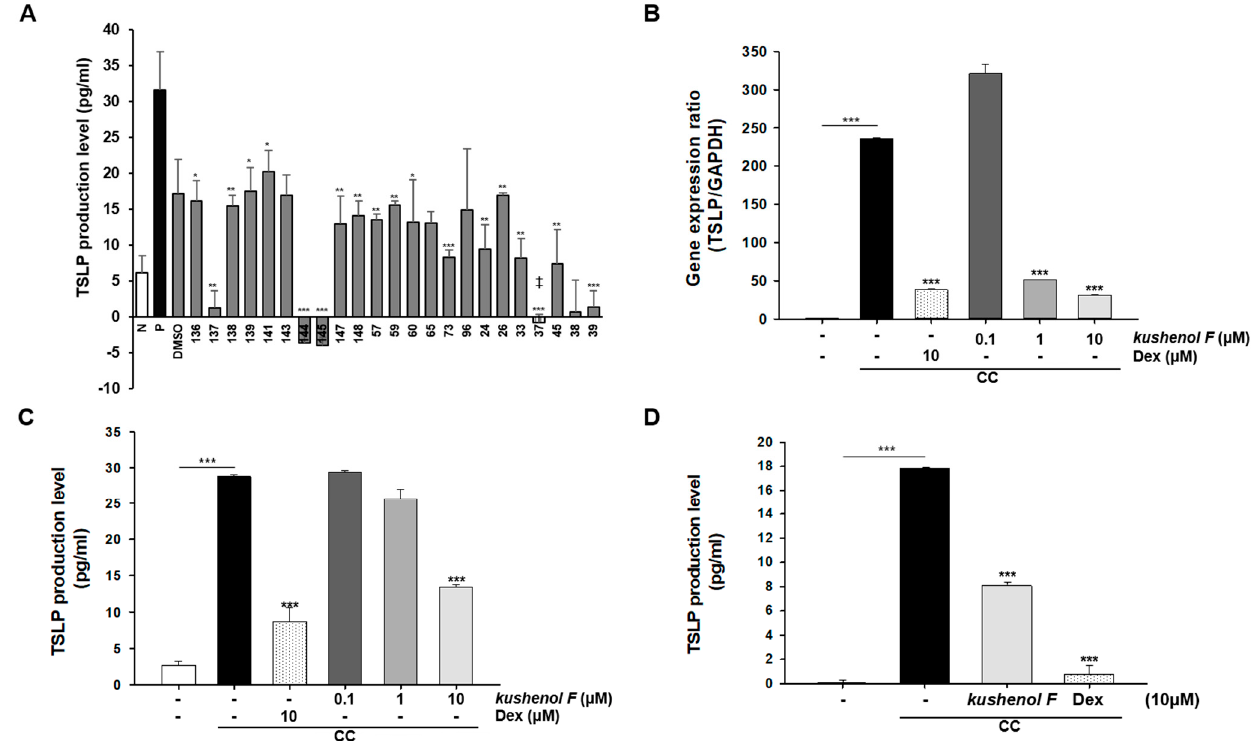
Figure 1. Screening for inhibitor of TSLP production and expression. ( A ) Pre-screening results of 23 natural compounds. TSLP production was determined following 24 h of treatment. NHEKs were pretreated with kushenol F for 1 h and were subsequently stimulated with CC for 4 h. ( B ) mRNA expression levels of TSLP were analyzed using reverse transcription-quantitative PCR and ( C ) TSLP concentration was quantified using ELISA. ( D ) HSEMs were pretreated with kushenol F for 1 h and then stimulated with CC for 4 h. TSLP concentration was quantified using ELISA. Data are presented as the mean ± SD of three independent experiments. ‡, kushenol F . * p < 0.05, ** p < 0.01 and *** p < 0.001 vs. control. TSLP, thymic stromal lymphopoietin; NHEK, normal human epithelial cells; CC, cytokine-combination; HSEM, human skin-equivalent model.